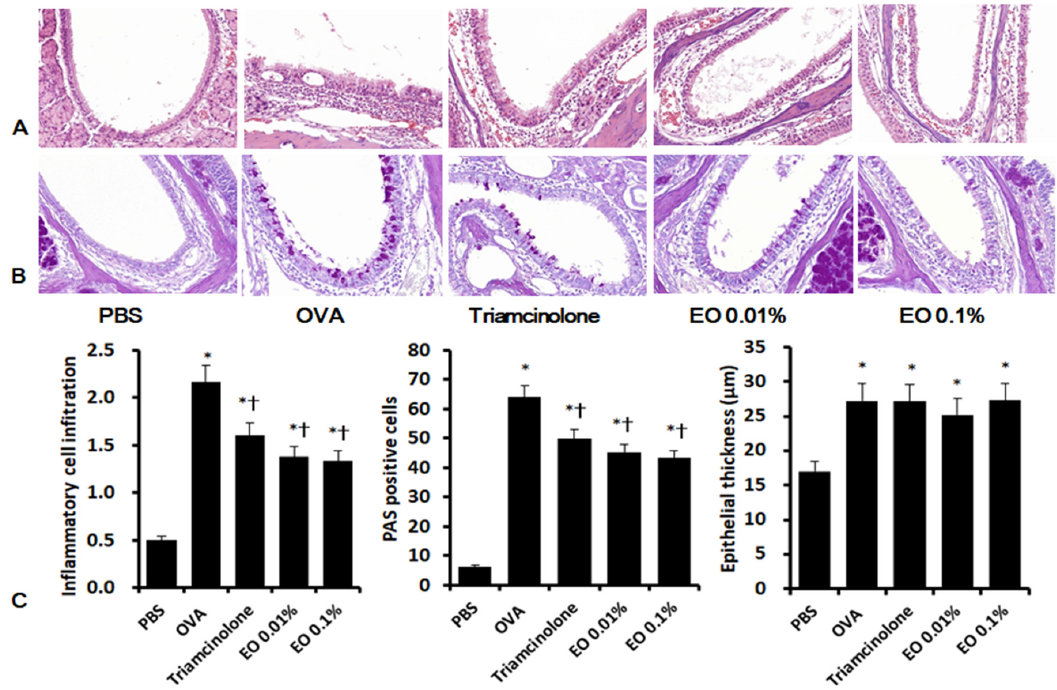
Figure 4. Effects of essential oil from Chamaecyparis obtusa (EOCO) on the histologic characteristics of sinonasal mucosa (n = 4 mice pergroup). Inflammatory cell infiltration and periodic acid-Schiff (PAS)-positive cells were significantly decreased by intrannasal EOCO instillation ( C ). A , representative photographs of hematoxylin and eosin (H&E) stained tissues; B , representative photographs of PAS stained tissues; PBS, phosphate-buffered saline; OVA, ovalbumin; * p < 0.05 versus the PBS group; † p < 0.05 versus the OVA group.